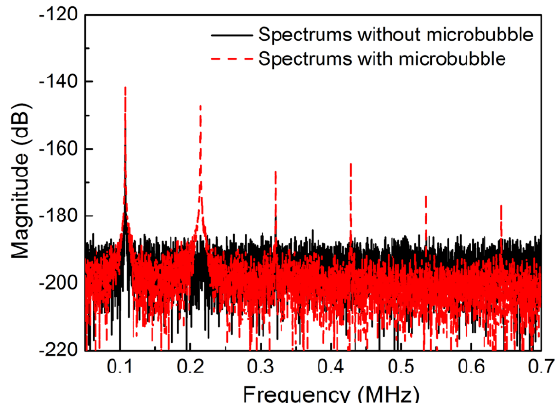
Figure 5. Microbubble stable cavitation. Higher harmonics are detected, illustrating that stable cavitation occurred (red dashed line). Without microbubbles, only the fundamental frequency spectrum can be detected (black line).